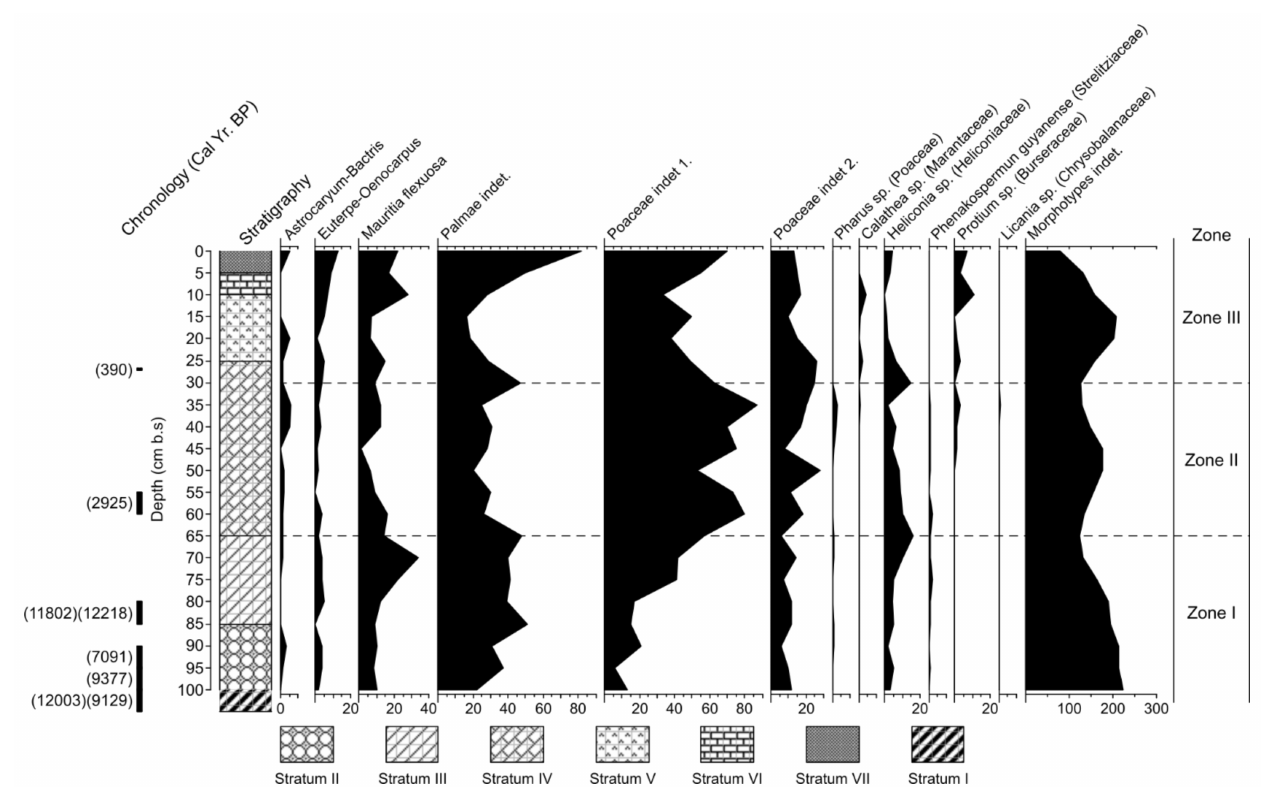
Figure 5. Phytolith diagram from Excavation Unit 1 from Cerro Azul. Reprinted from Morcote-Rios et al. [18], with permis- sion from